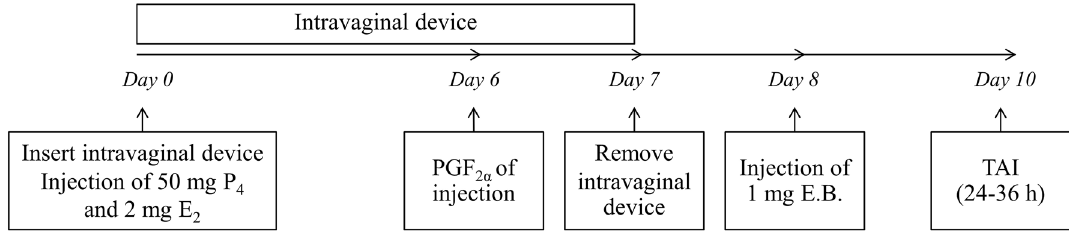
Figure 1. The synchronization protocol. Intravaginal device (CIDR, DEC International NZ Limited, Hamilton, New Zealand), PGFα (JURAMATE, Jurox Pty. Limited, NSW, Australia), progesterone (P 4 ), estradiol 17 β (E 2 ) and estradiol benzoate (EB) (Steraloids Inc., Newport, RI,